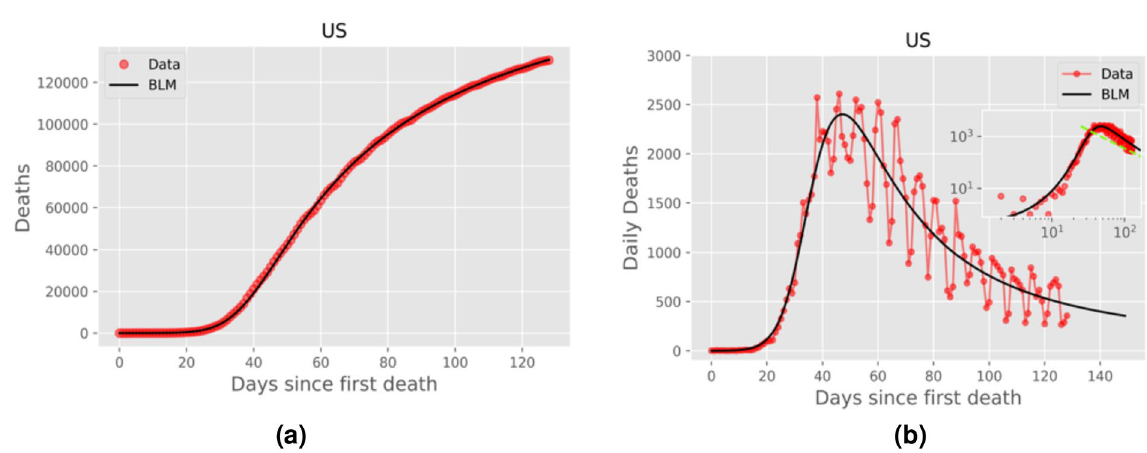
Figure 5. Same as in Fig. 2 for the United States, but here the data is up to July, 07,